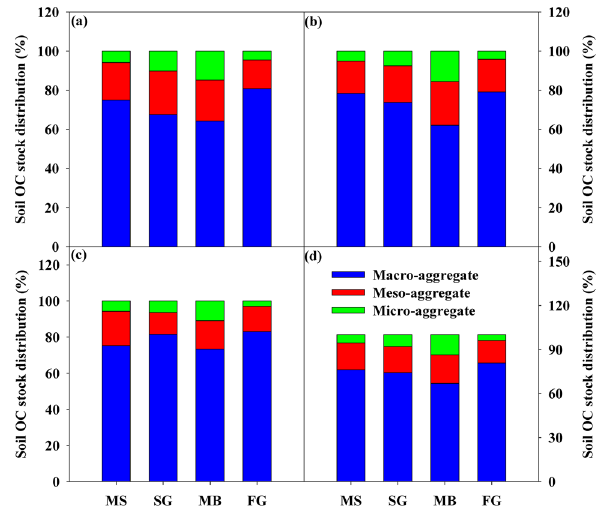
Figure 4. The relative distribution of OC stocks in different soil aggregate fractions at ( a ) 0–10 cm, ( b ) 10–20 cm, ( c ) 20–30 cm and ( d ) 0–30 cm), respectively. Each point represents mean value. MS: maize-soybean;